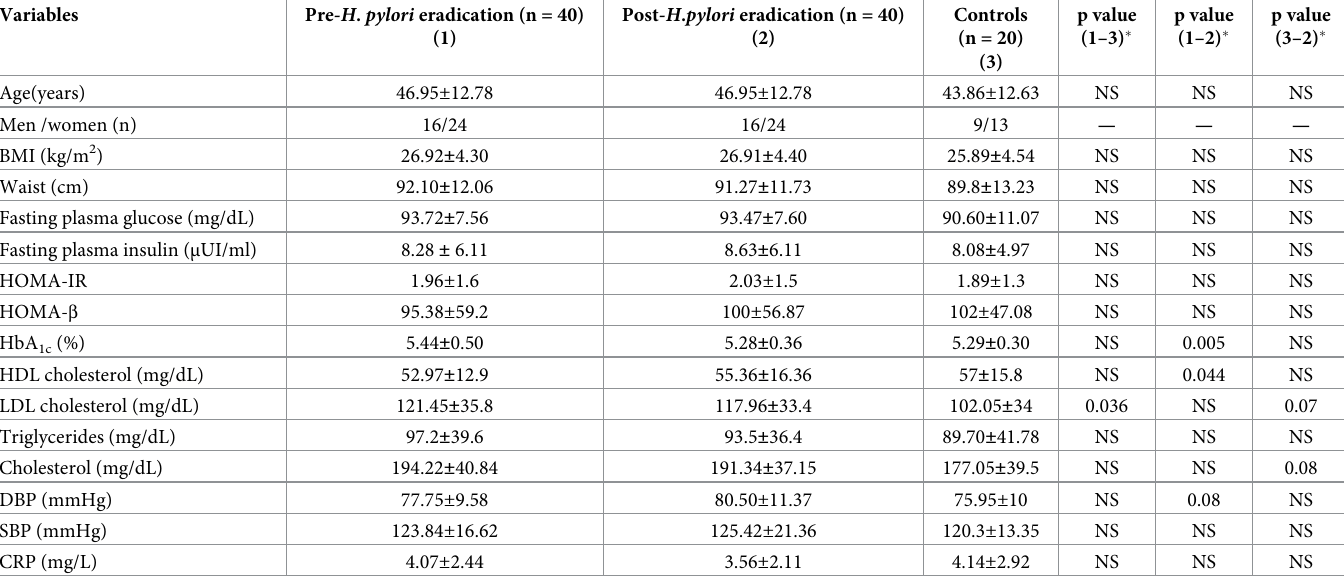
Table 1. Anthropometric and biochemical variables.